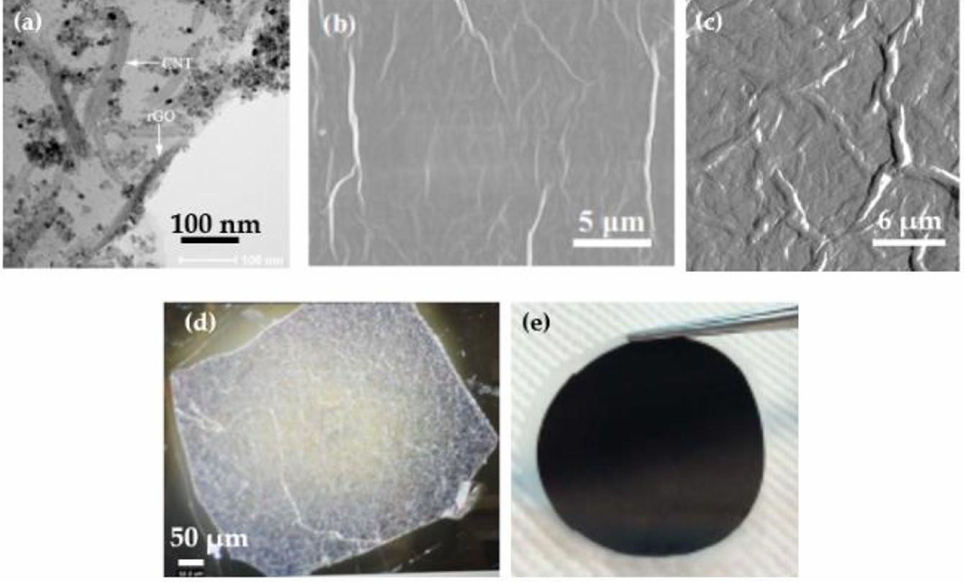
Figure 8. ( a ) TEM image of graphene oxide/CNTs/TiO 2 layer [59], ( b ) SEM image of graphene oxide/CNTs membrane [37], ( c , d ) AFM and optical microscope images of graphene oxide membrane (performed in Universidad del Pais Vasco/Euskal Herriko Unibertsitatea—UPV/EHU laboratories, Bilbao, Spain), ( e ) a photograph of a graphene/CNTs membrane on PTFE [39]. Subfigures ( a , b , e ) have been adapted/reproduced from references [37,39,59] with permission from Elsevier, MDPI, and the Royal Society of